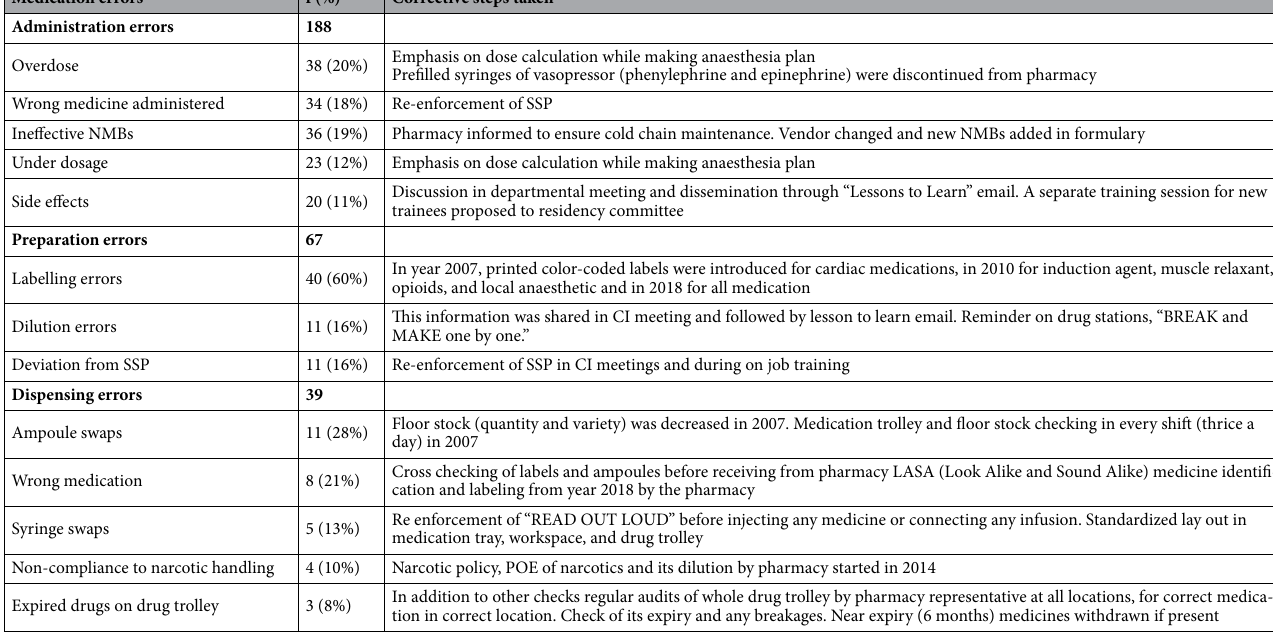
Table 2. Medication errors during drug administration, preparation, and dispensing along with corrective measures taken (2004–18). SSP Syringe Standardization Policy, NMB Neuromuscular blocker, POE Patient Order